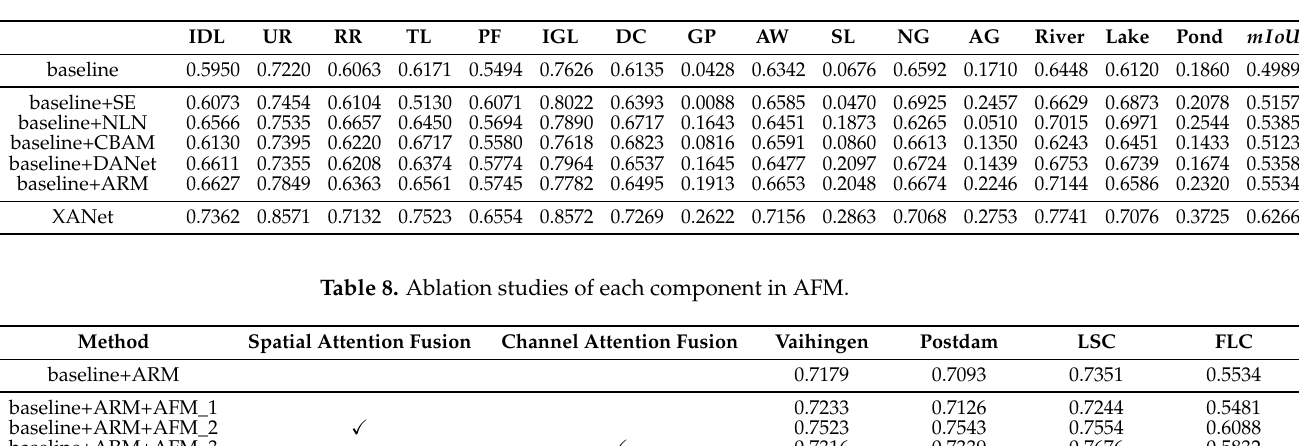
Figure 14. Comparison of segmentation results on the FLC dataset: ( a ) Image; ( b ) Ground truth; ( c ) Baseline; ( d ) Baseline+ SE; ( e ) Baseline+ NLN; ( f ) Baseline+CBAM; ( g ) Baseline+DANet; ( h ) Base- line+ARM,; and ( i ) XANet. Table 7. Accuracy comparison of different attention modules on the FLC dataset.